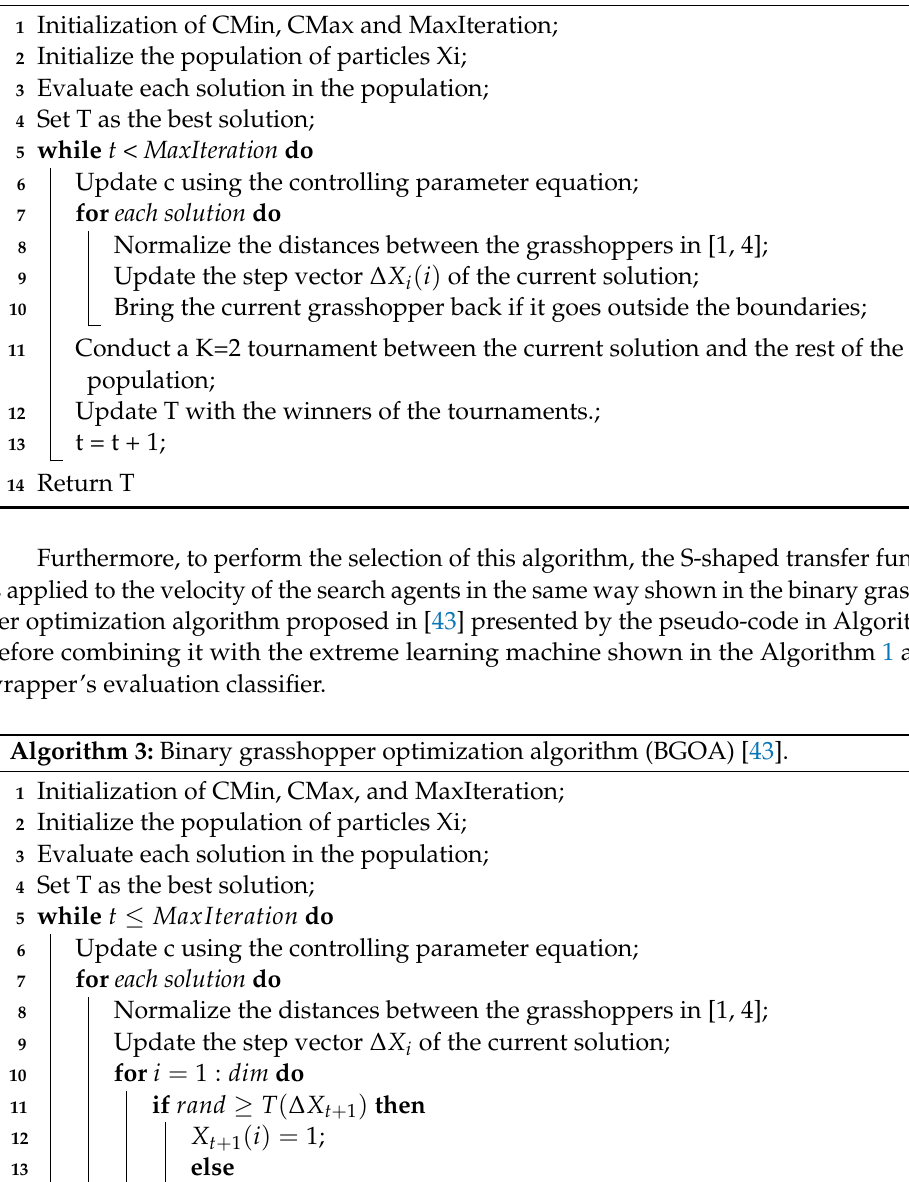
Algorithm 2: k-Tournament grasshopper optimization algorithm.